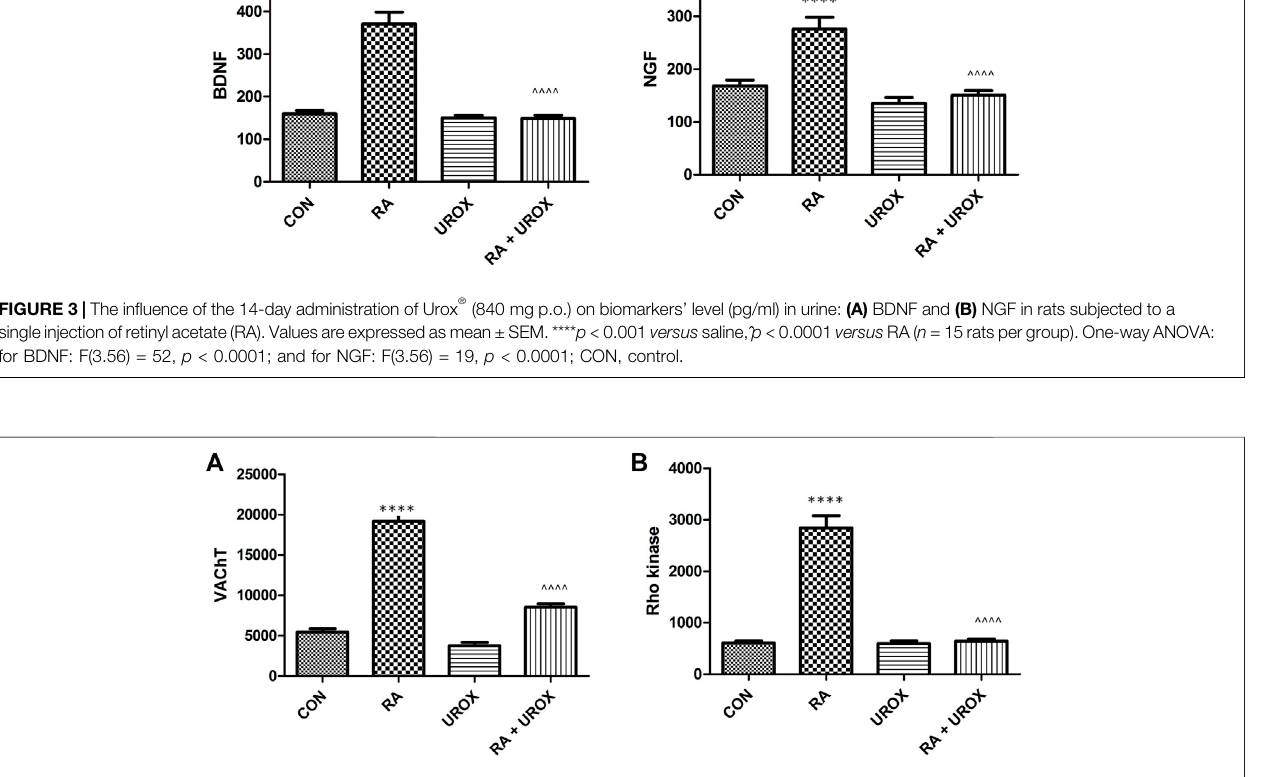
FIGURE 4 | The in fl uence of the 14-day administration of Urox ® (840 mg p.o.) on biomarkers ’ level (pg/ml) in the bladder detruso r muscle: (A) vesicular acetylcholine transporter (VAChT) and (B) Rho kinase. Values are expressed as the mean ± SEM. **** p < 0.001 versus saline, ^^^^ p < 0.0001 versus RA ( n = 15 rats per group). One-way ANOVA: for VAChT: F(3.56) = 97, p < 0.0001 and for Rho kinase: F(3.56) = 80, p < 0.0001. CON,